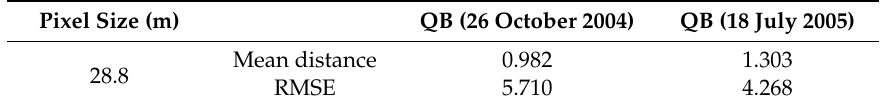
Table 1. Mean displacement and RMSE (in m) between sub-pixel coastlines—automatically obtained from two downsampled QuickBird images (QB) and their respective reference lines.